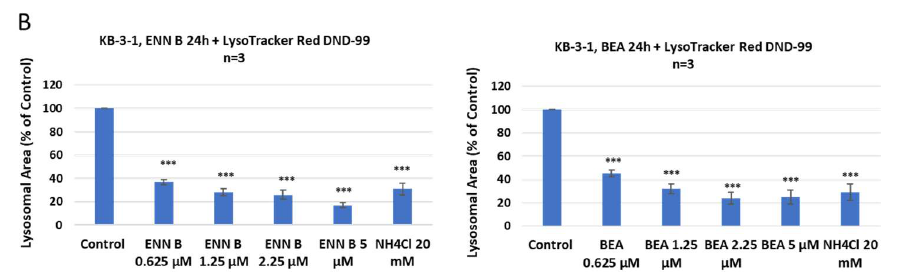
Figure 1. Effect of ENN B and BEA treatment on the lysosomal staining by LysoTracker red. ( A ) Fluorescence micrograph of KB-3-1 cells treated for 24 h with different concentration of ENN B or BEA prior incubation with LysoTracker red; ammonium chloride treated cells were used as a posi- tive control. Each image represents a single cell from three different experiments. ( B ) Proportion of lysosomal area per cell after 24 h treatment +/− ENN B or ammonium chloride, the area of the control cells was set to 100%. The data were analyzed using one way ANOVA with Dunnett’s post hoc analysis (*** p < 0.001; N = 7). Statistics was calculated using GraphPad Prism (N = samples/group and n = experiment replicates).